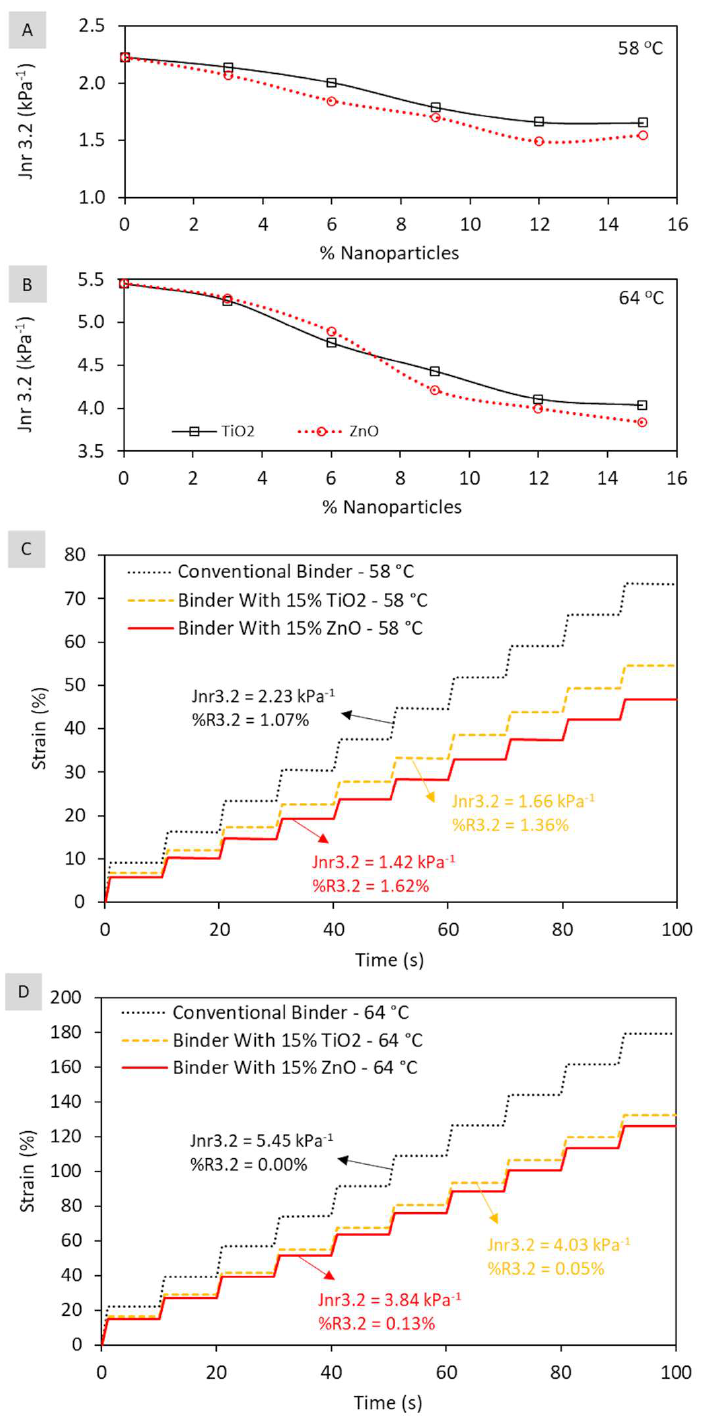
Figure 7. Behavior of asphalt matrices (after RTFOT) in terms of creep and recovery during the MSCR test at stress of 3.2 kPa: non-recoverable creep compliance as a function of the percentage of nanoparticle at temperature of 58 °C ( A ) and at temperature of 64 °C ( B ) and comparison of creep and recovery curves of the conventional binder in relation to composites with 15% TiO 2 and 15% ZnO at temperature of 58 °C ( C ) and at temperature of 64 °C ( D ).